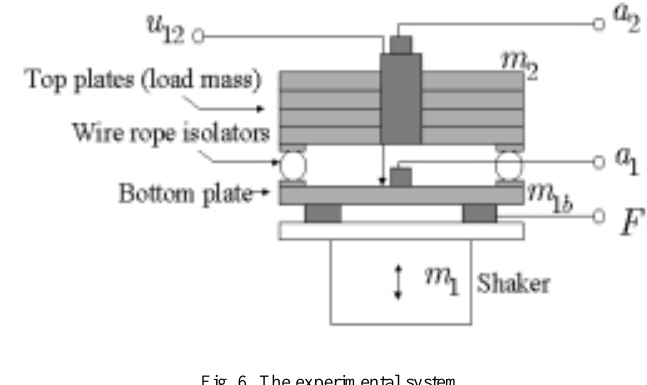
Fig. 6. The experimental